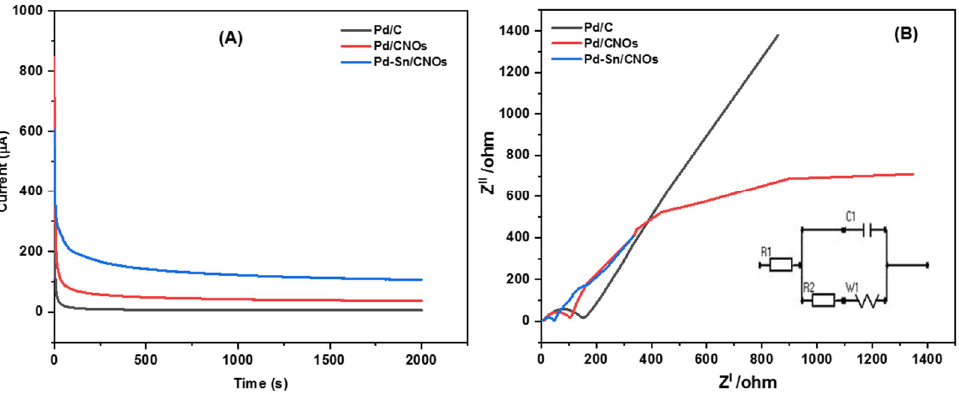
Figure 8. Chronoamperograms ( A ) and Nyquist plots with corresponding equivalent circuit ( B ) of Pd/C, Pd/CNO, and Pd-Sn/CNO electro-catalysts in 1 M KOH + 1 M CH 3 OH solution.